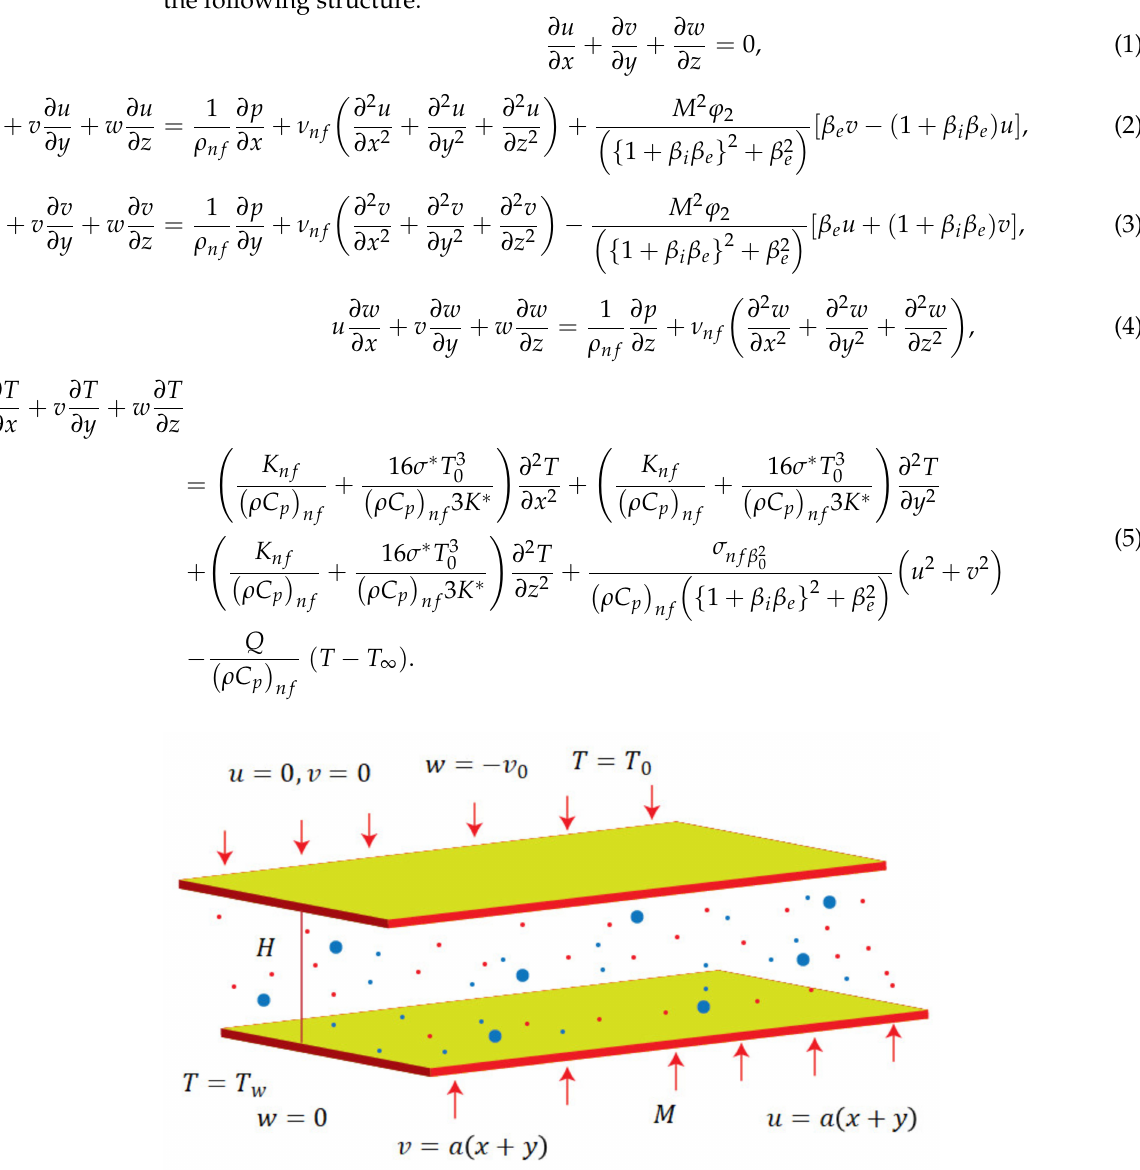
is uniformly injected and lower boarder of the channel at z = 0 is stretched in x —and y — direction with same rates. A steady flow of the fluid is induced due to stretching the lower wall of the channel with same velocities in opposite direction with same rates as shown in Figure 1. The applied electric field is to be considered insignificant. Also, Joule heating, viscous dissipation, and thermal radiations are considered. Conservation laws [29,30] take the following structure.